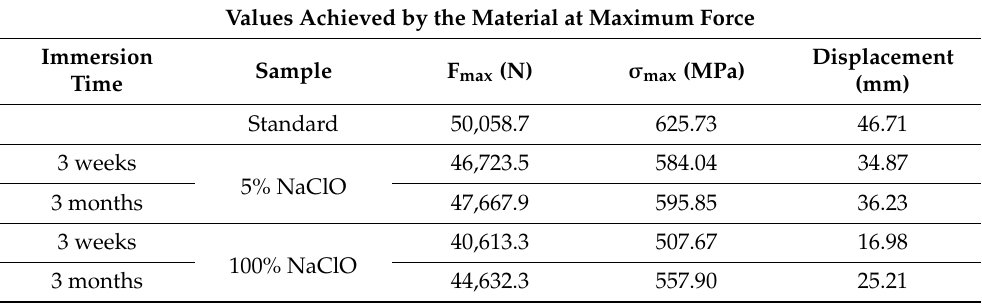
Table 2. Values reached by the AISI 321 after three weeks and three months at maximum force.